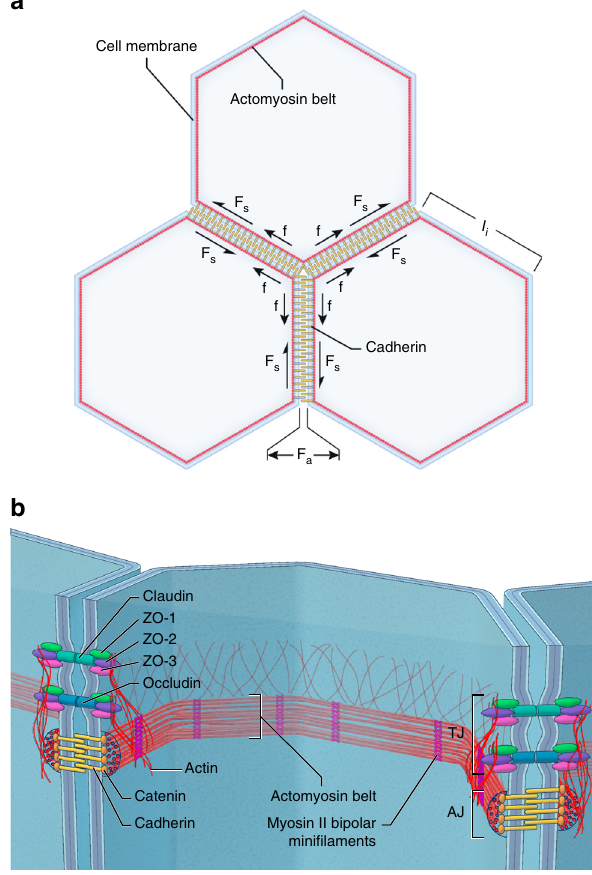
Fig. 1 Critical intra- and intercellular forces acting within a polarized epithelium and key molecular structures. a The illustration shows the working model for polarized epithelium tension and intercellular adhesion forces. Cell – cell contacts transmit mechanical tension through a dynamic coupling between adherens and tight junctions and the perijunctional actomyosin cytoskeleton. The epithelium contractility generates an isotropic tension balanced by the intercellular normal and shear adhesive forces. The free body diagram presents the variables used in our theoretical model where; f is the pulling force acting at tricellular junctions, F NA is the intercellular normal adhesive force, F SA is the intercellular shear adhesive force, and l i is the cell edge length. b Diagram illustrating the localization and molecular structural composition of the actomyosin cytoskeleton belt interacting with tight and adherens junctions. In the tight junctions the ZO- 1, ZO-2, and ZO-3 proteins bind to the transmembrane receptor proteins claudins and occludins and to the perijunctional actin cytoskeleton plaque. In the adherens junctions catenin proteins bind to the transmembrane cadherins and to the actomyosin belt with large F-actin bundles and bipolar myosin II bipolar mini fi laments